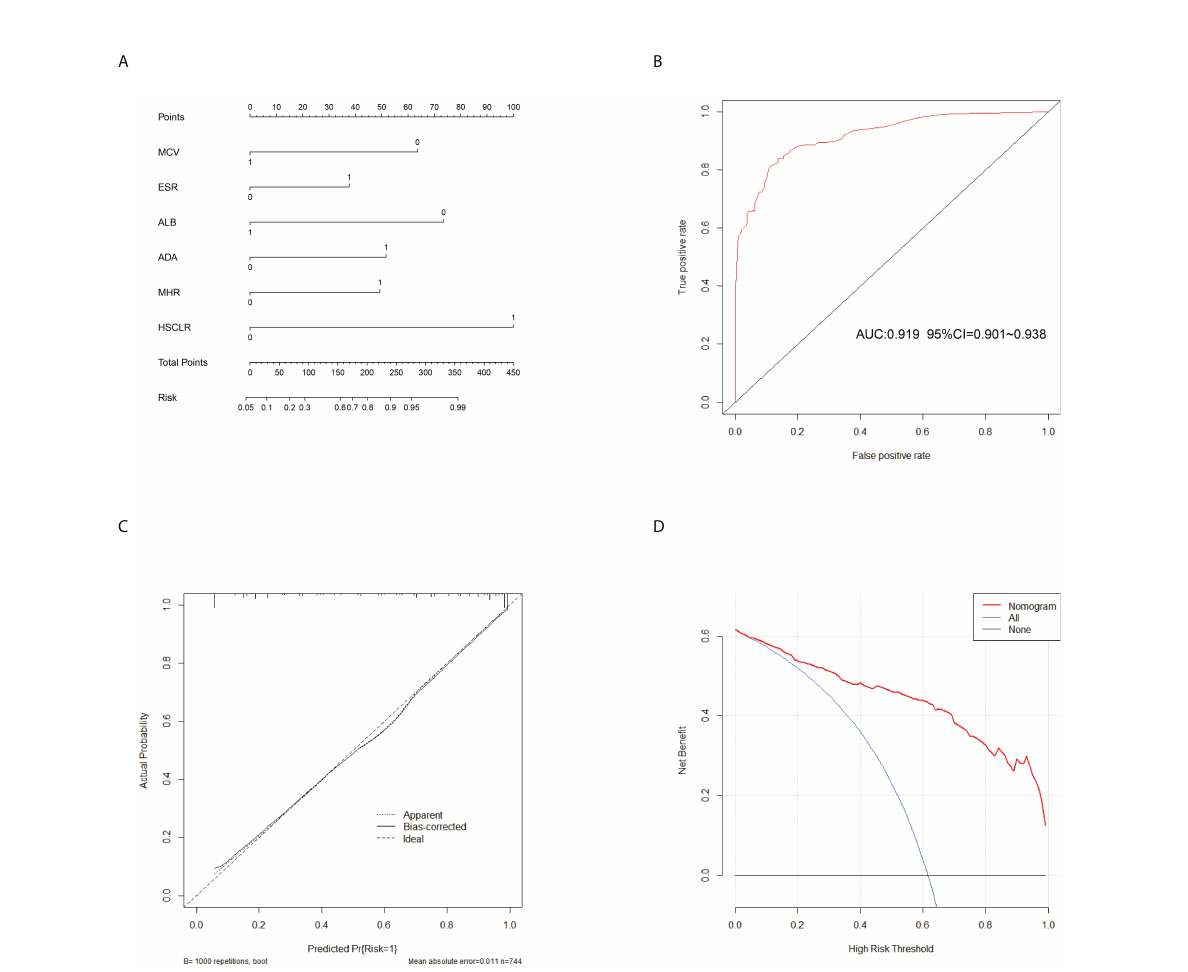
FIGURE 3 Calibration and clinical use of a diagnostic nomogram for the identi fi cation of APTB and IPTB. (A) Diagnostic nomogram for discriminating APTB from IPTB. (B) The ROC analyses for the Diagnostic model. (C) Calibration curve of the diagnostic nomogram. (D) DCA of the diagnostic nomogram.